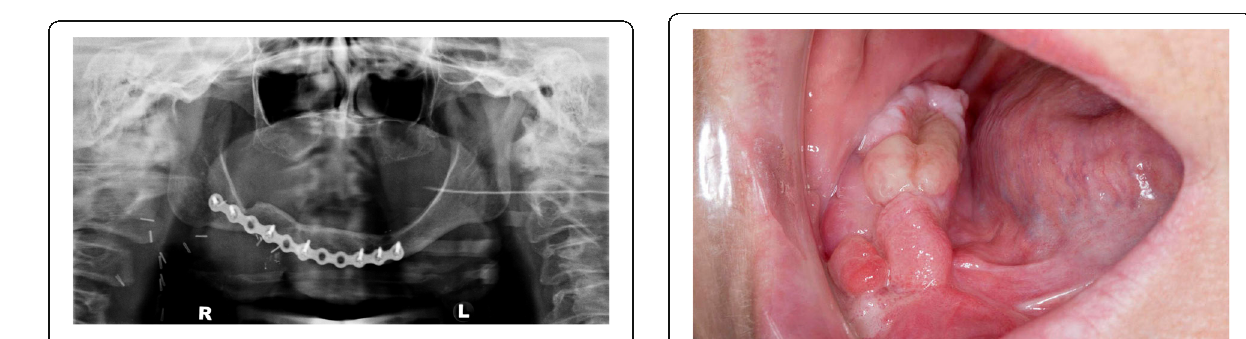
Fig. 1 Panoramic radiograph showing segmental mandibulectomy and reconstruction